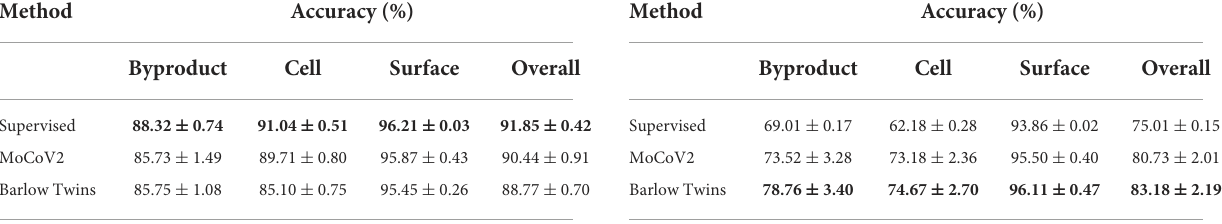
TABLE 1 Classification accuracy percentages under linear evaluation on Biofilm dataset.